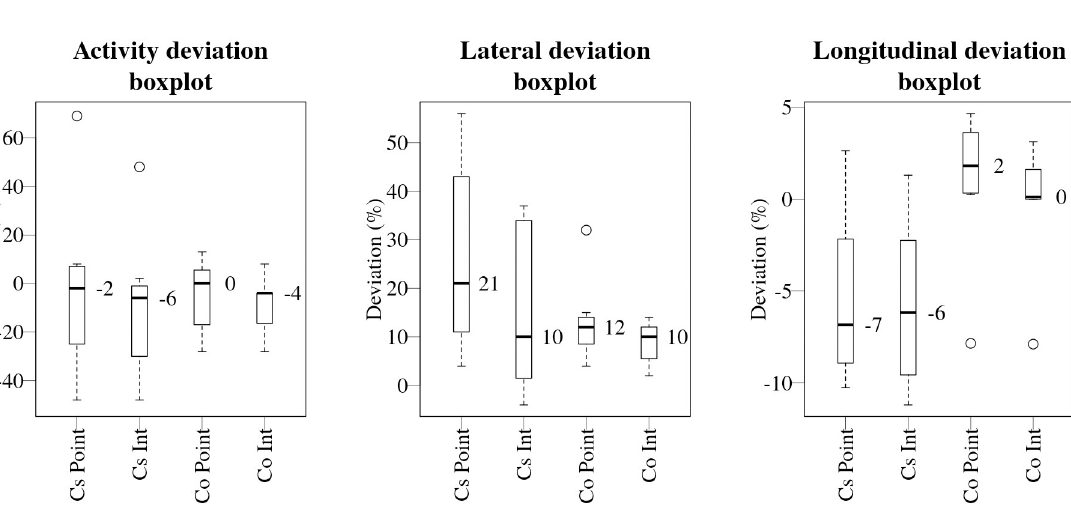
Fig 10. Boxplot comparison for activity, lateral and longitudinal (from left to right) deviations obtained using point and integrated estimates for 137 Cs and 60 Co radionuclides. Median values are marked with thick black lines and expressed in numbers to the right of the median